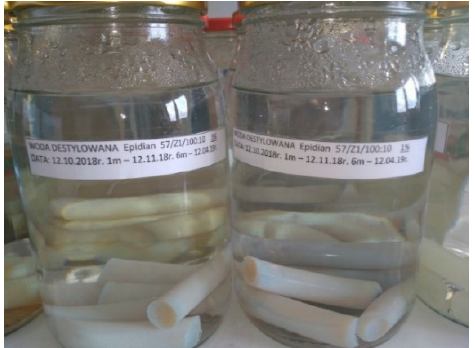
Figure 3. The examples of two glass vessels with E57/Z-1/10:1 epoxy compound samples immersed in rainwater and tap water.